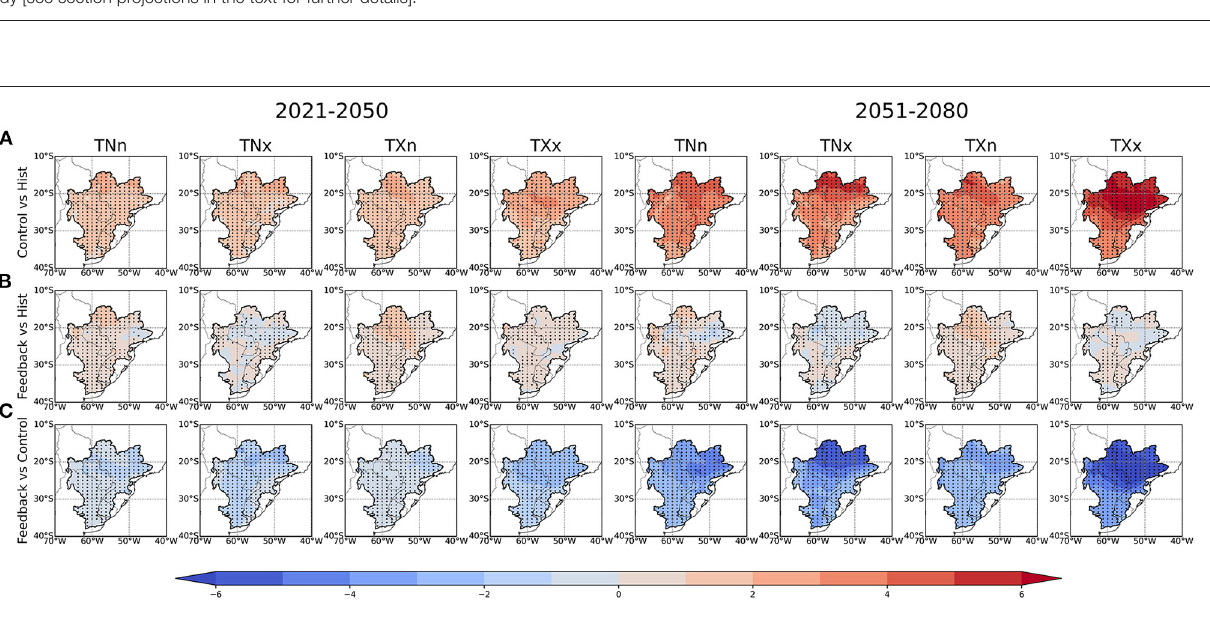
Frontiers in Climate |